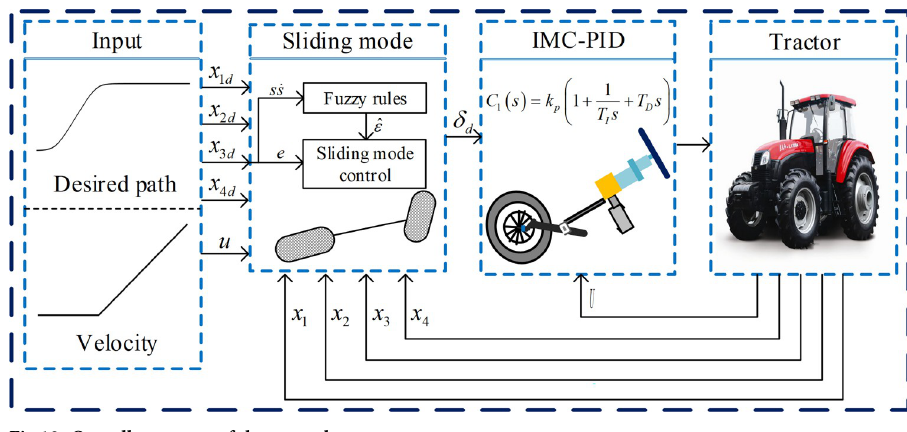
Fig 10. Overall structure of the control